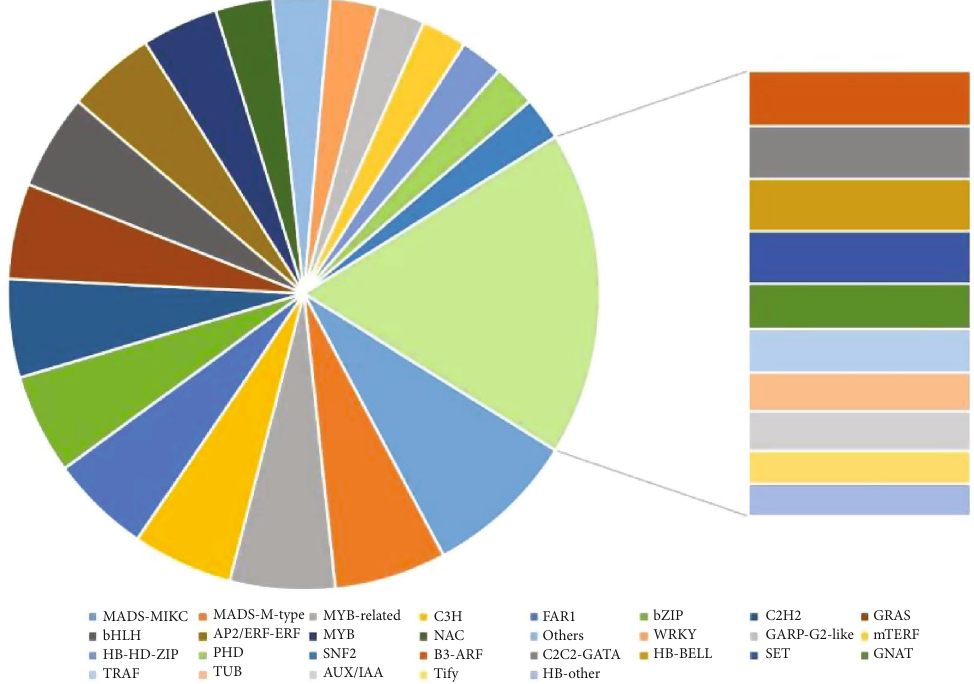
Figure 1: The transcript (38,707) and unigene (15,608) length distribution in tiger lily sepals. Table 2: Summary of the unigenes mapped to KEGG functional pathways. Pathway Number Pathway ID